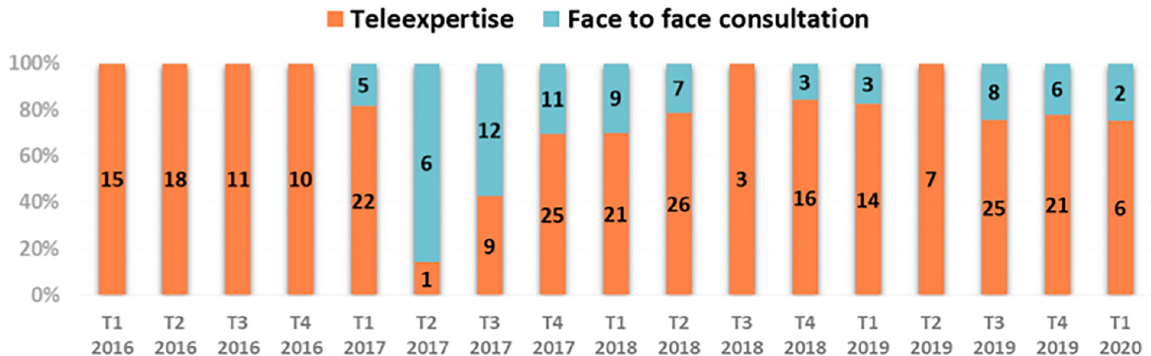
Fig 1. Breakdown by calendar quarter of the 322 advices requested by the 260 patients according to whether they were seen face-to-face or tele-expertized.